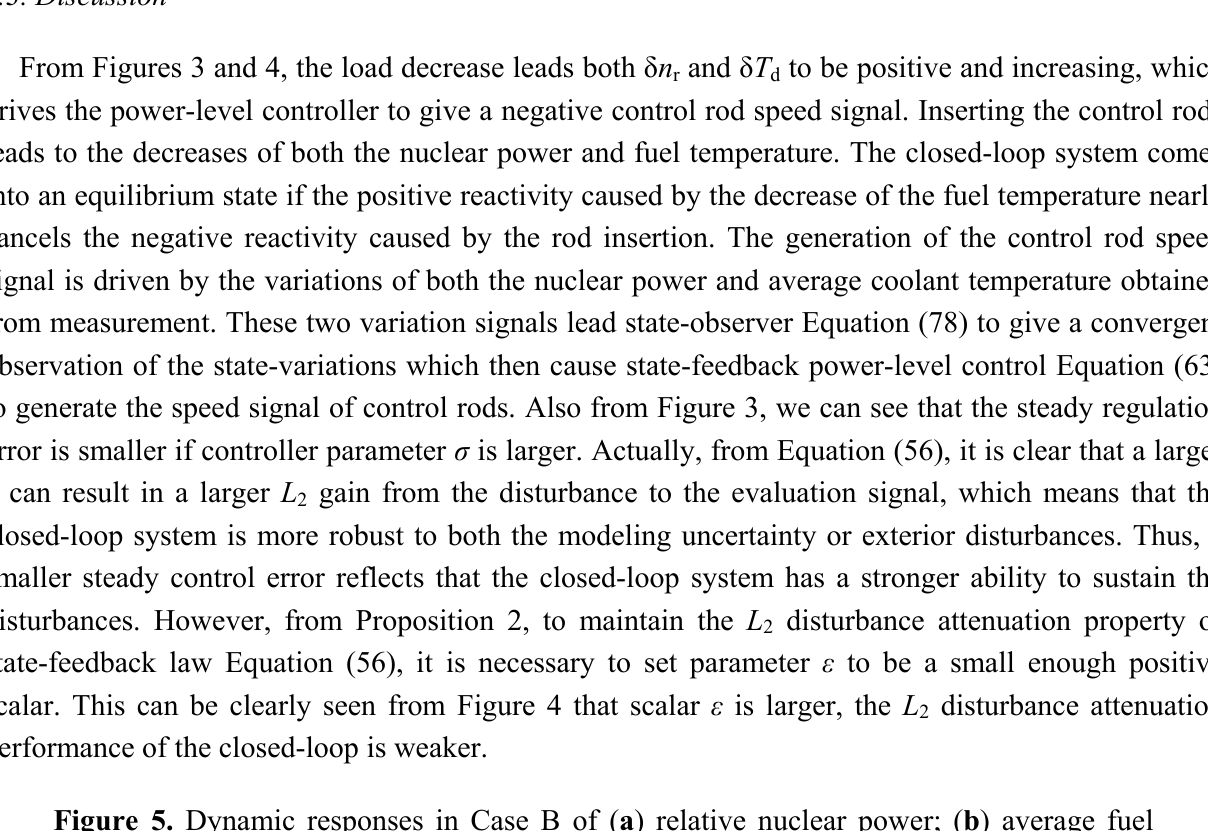
Figure 5. Dynamic responses in Case B of ( a ) relative nuclear power; ( b ) average fuel temperature; ( c ) outlet helium temperature and ( d ) control rod speed signal with different σ and constant ε